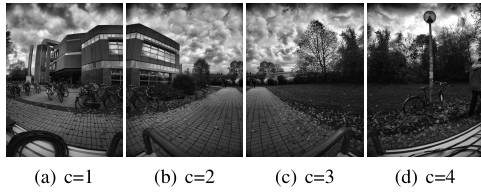
Figure 6: Sample images of the ladybug3 data